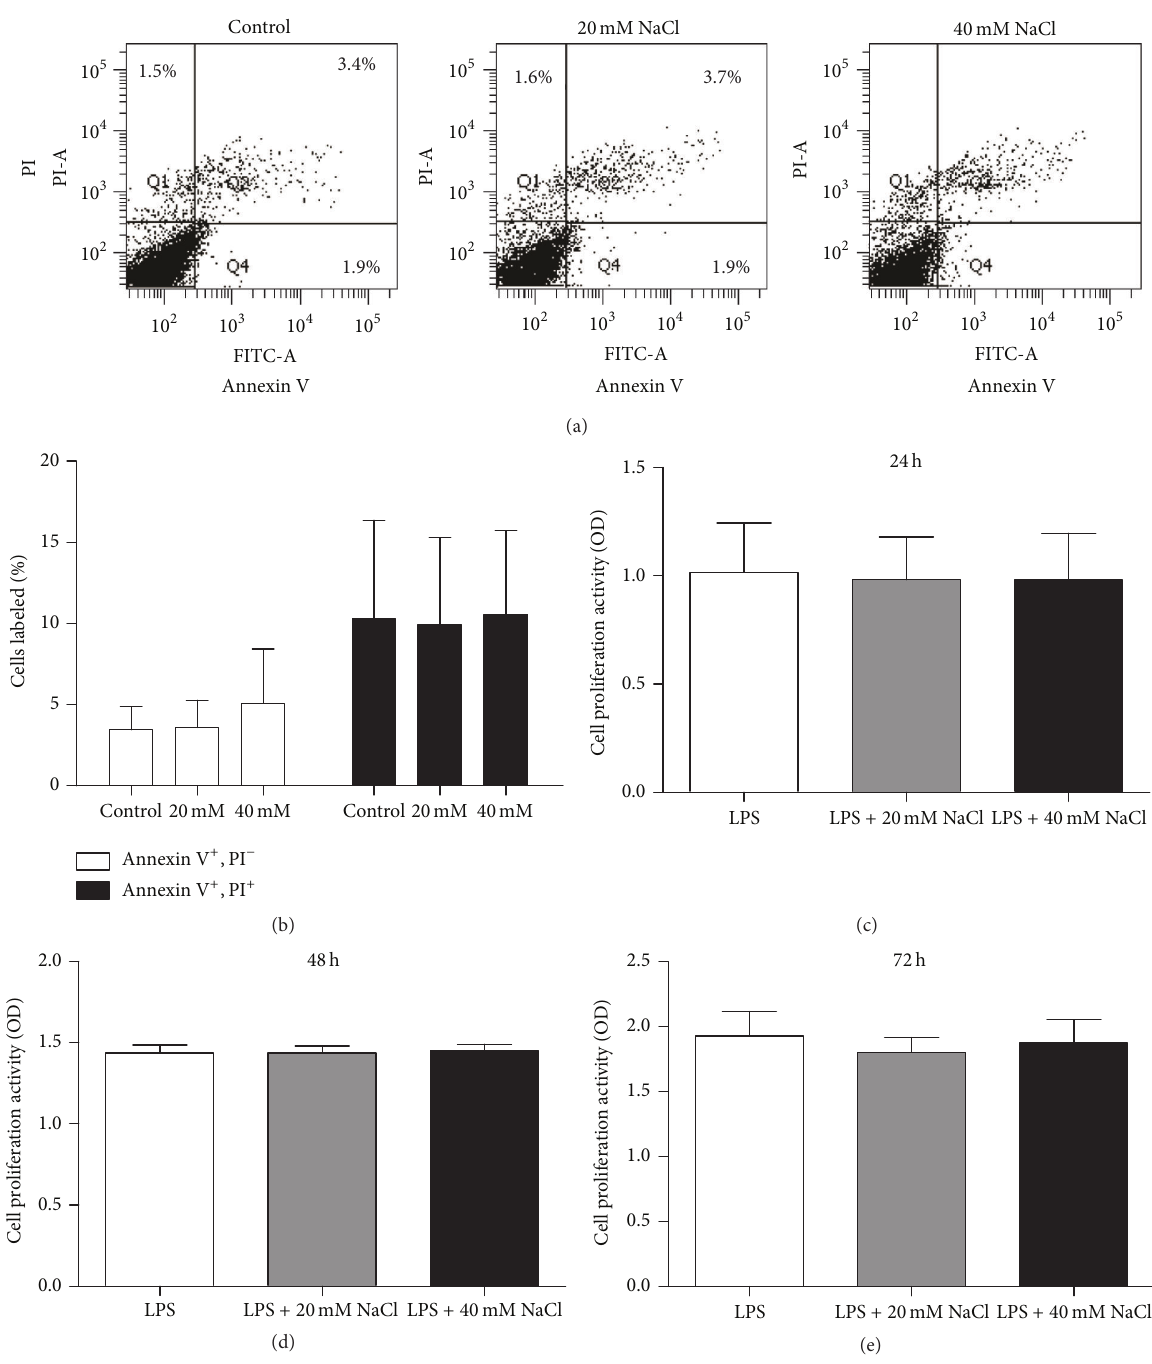
Figure 1: NaCl had no influence on the apoptosis and proliferation of ARPE-19 cells. ARPE-19 cells were stimulated with LPS in the absence or presence of extra additions of NaCl (20mM, 40mM) to the culture medium for 24 h. Cells were stained with annexin V and PI for FACS analysis. (a) Apoptotic cells (annexin V + PI − ) are shown in the Q4 area; late apoptotic cells (annexin V + PI + ) are shown in the Q2 area; necrotic cells (annexin V − PI + ) are shown in the Q1 area. (b) The percentages of cells labeled as annexin V (+) PI (−) and annexin V (+) PI (+) were employed for analysis. The data are expressed as means ± SD of three independent experiments and there were no significant differences between the groups, 𝑛 = 7 . To detect the proliferation of ARPE-19, the cells were plated with medium alone or medium with extra NaCl (20mM or 40 mM) for 24 h (c), 48h (d), and 72 h (e) following LPS stimulation and then measured using the CCK-8 method. Data shown are the mean ± SD of the ratio for light absorbance at 450 nm. Results are representative of three separate experiments, 𝑛 = 6 . Paired-samples t -test (when the difference between the two tested groups conforms to normal distribution) or Wilcoxon matched-pairs test (when the difference between the two tested groups does not conform to normal distribution) was used for statistical analyses for LPS control versus LPS + 20 mM NaCl or LPS + 40 mM NaCl in each